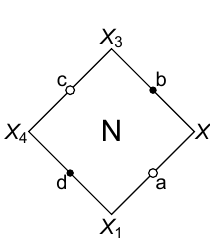
Figure 22 . An elementary patch on the worldsheet. X i are points in spacetime, N is the normal vector of the patch. The variables a, b, c, d are those that appear in eq.